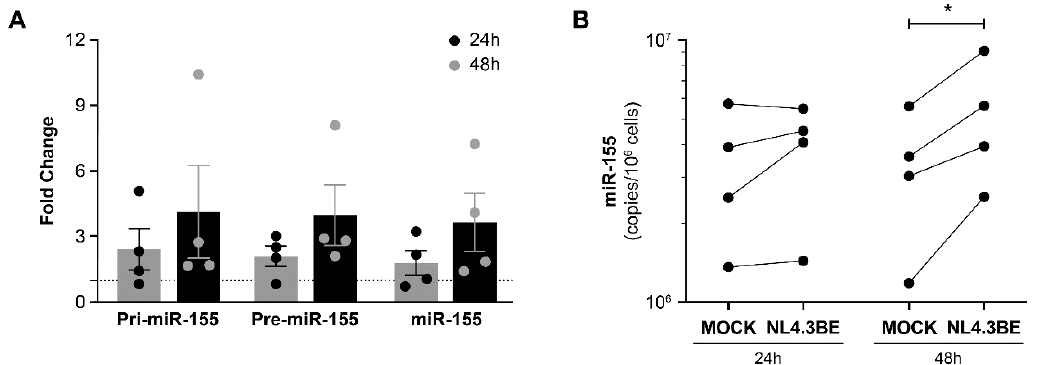
Figure 1. HIV increases precursor and mature miR-155 expression in PBMCs. PBMCs freshly isolated from HIV-negative donors (n = 4) were incubated with NL4.3Bal env virus (100 ng of p24 per 10 6 cells) or diluent for 2 h, washed three times with PBS to eliminate free virus, then incubated for 24 h or 48 h. ( A ) Pri-miR-155, pre-miR-155, and miR-155 expression by HIV-infected PBMCs in comparison to their expression in mock-treated PBMCs, the latter being represented by the dotted line in the graph positioned at y = 1. Expression levels were measured by RT-qPCR. Fold change in the expression level was calculated as 2 - ΔΔ Ct with PPIA as the control gene. ( B ) Mature miR-155 concentration in PBMCs, calculated from a standard curve produced with synthetic miR-155. Each dot represents one donor. Significant difference (* p < 0.05) is based on parametric paired t-tests.